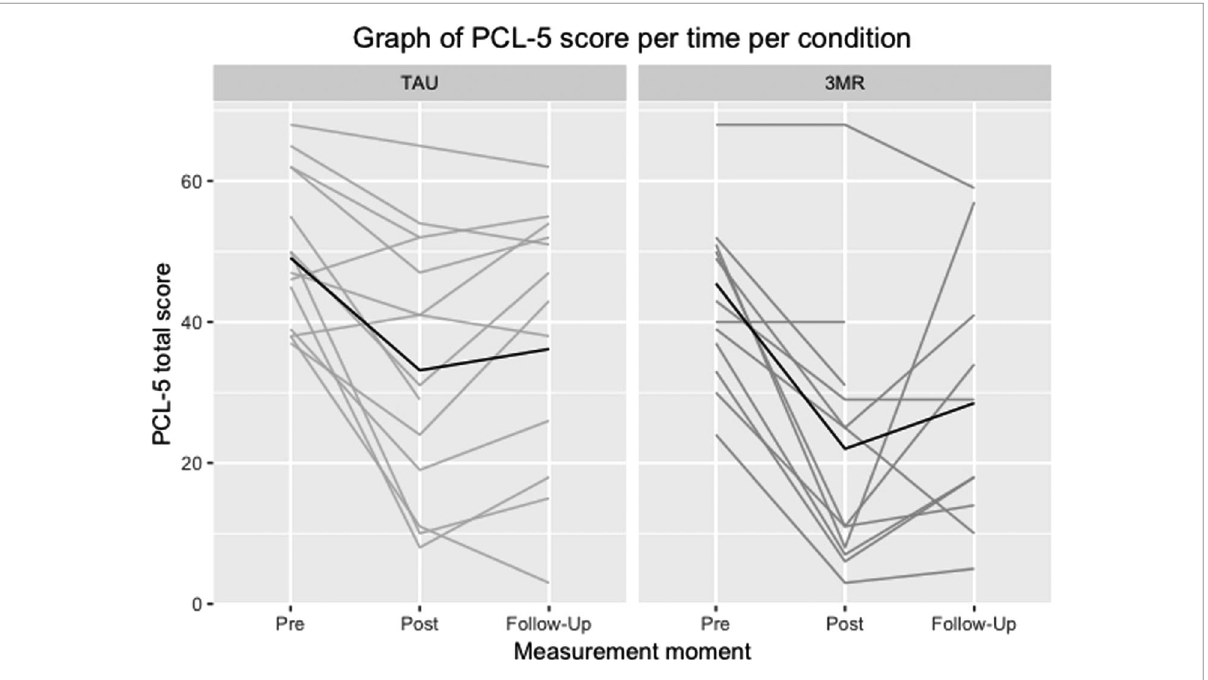
FIGURE 2 Individual patient trajectories over time for the PCL-5 in both treatment conditions, with the dark line representing the mean